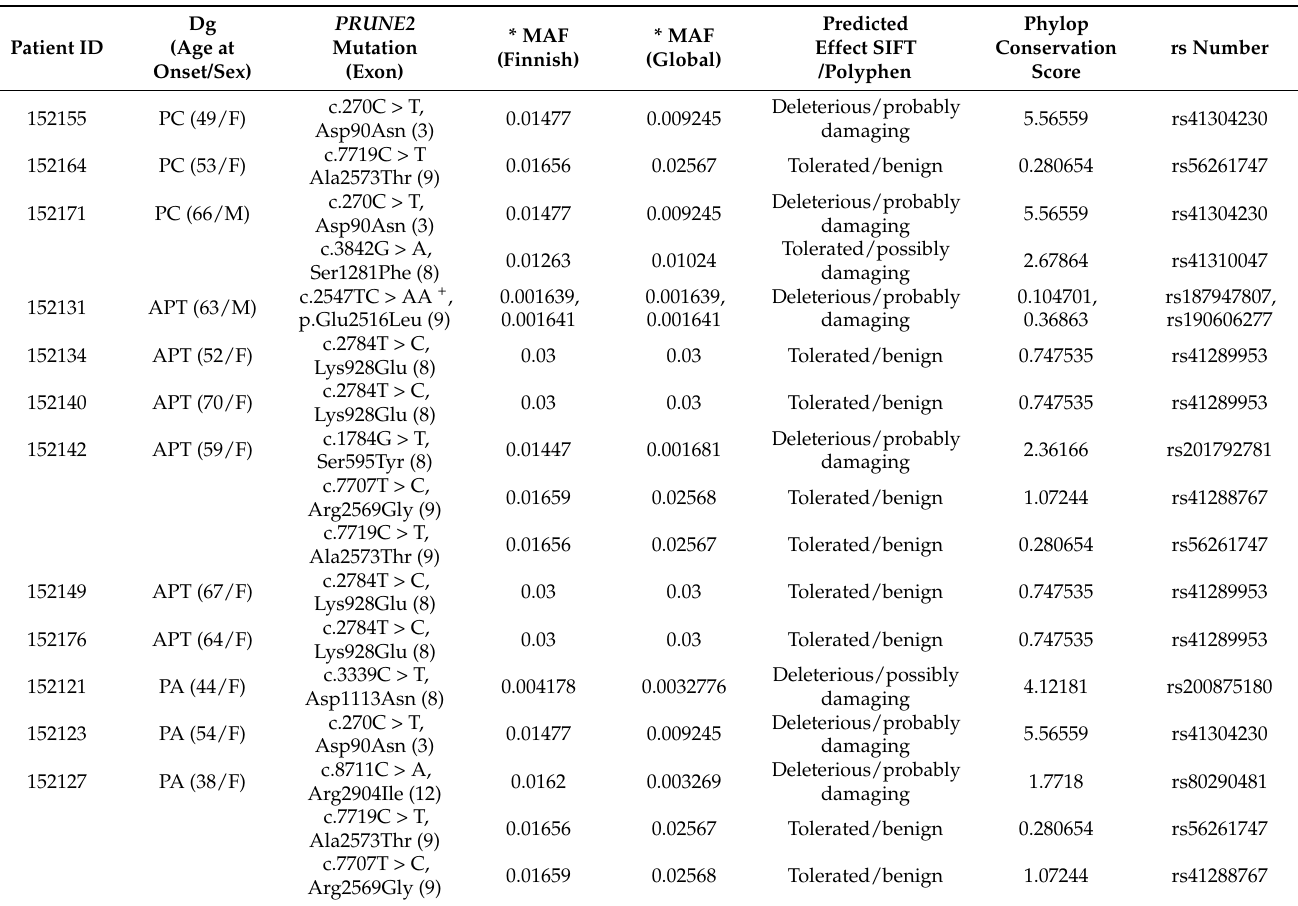
Table 3. Identified rare PRUNE2 germline mutations (MAF < 0.05) according to underlying tumor in 37 patients with primary